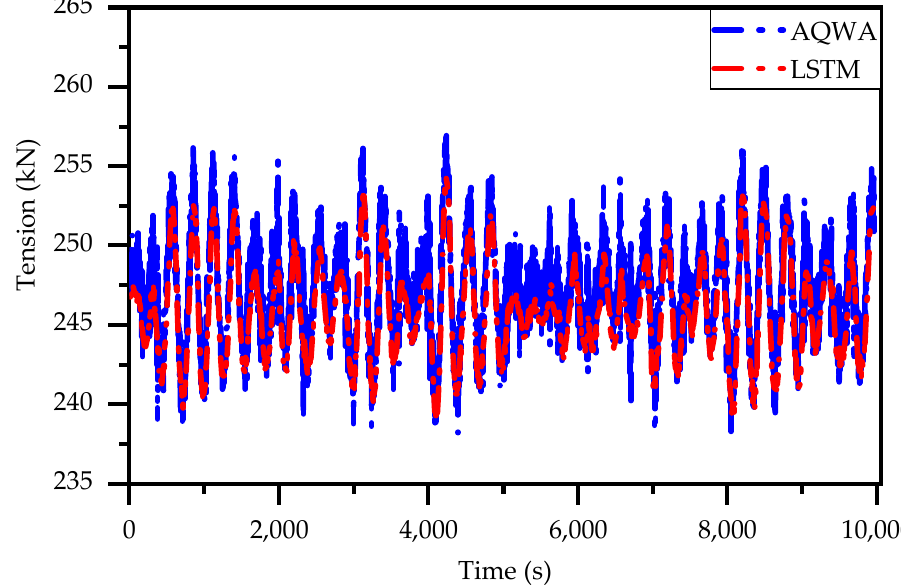
Figure 6. Time history curve comparison of AD10 Mooring Line 8.